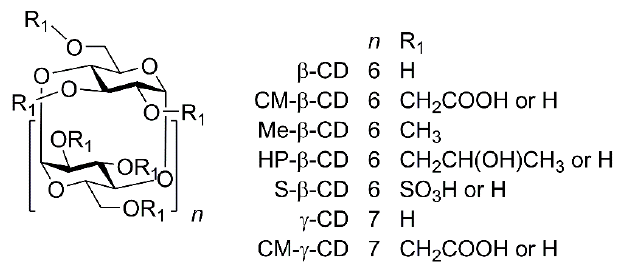
Figure 5. Structures of CDs derivatives used as chiral selectors.